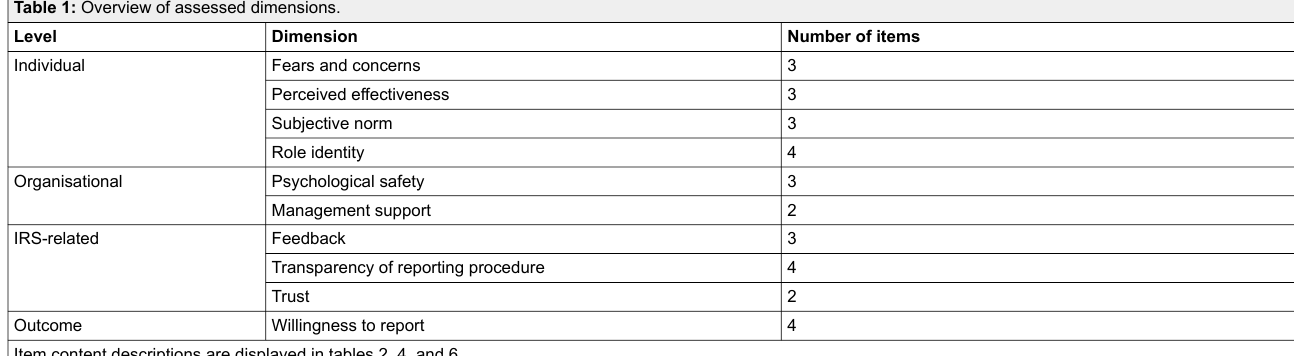
Table 1: Overview of assessed dimensions.